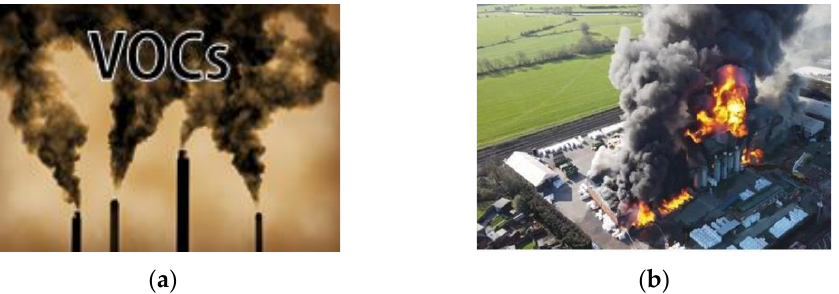
Figure 1. Environmental pollution and safety issues. ( a ) Air pollution caused by the incineration of waste resources. ( b ) Fire occurred during the manufacturing process of waterproofing material.